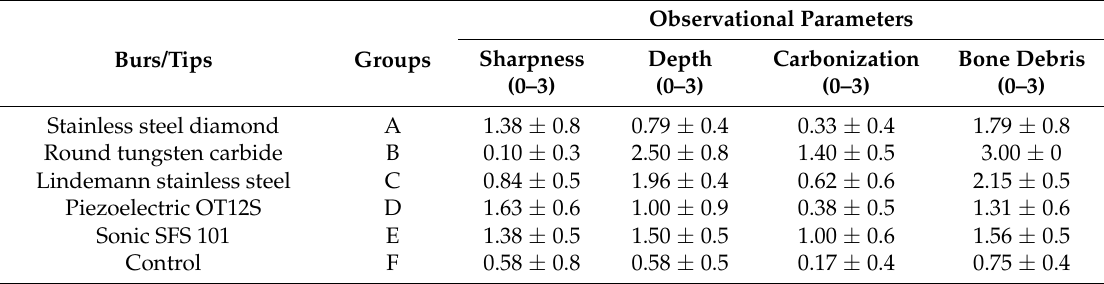
Table 1. Per group observational parameters (mean values and standard deviation).